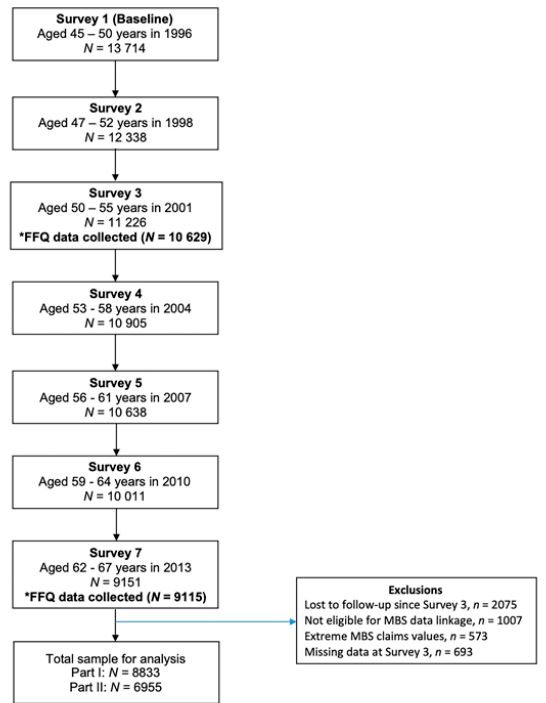
Figure 1. Flow chart of the participant selection using the 1946–1951 ALSWH cohort. Note: *FFQ, food frequency questionnaire; MBS, Medicare Benefits Schedule.